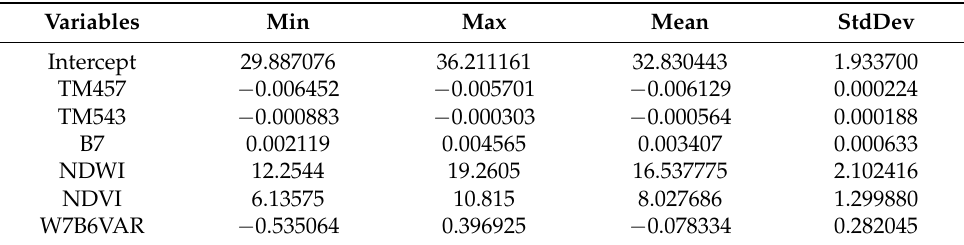
Table 3. Descriptive statistics of the local regression parameters of the GWR model.